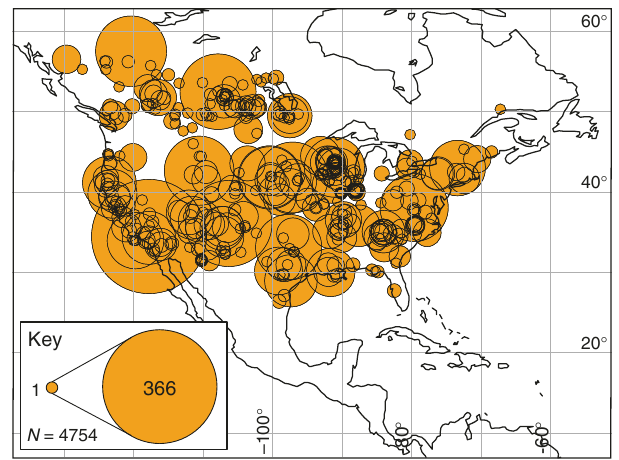
Fig. 1 Bubble plot showing distribution of alluvium accumulation rate data in the compilation. Bubbles indicate the study sites (400 in total) and the number of rate measurements from each site (4754 in total). See Supplementary Data 1 for full data